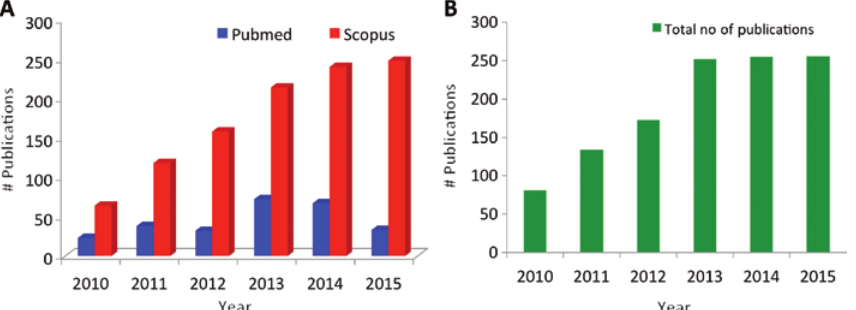
Figure 8: Publication trends. (A) Yearwise distribution of number of publications retrieved from Pubmed and Scopus. (B) Yearwise distribu- tion of the total number of publications from Pubmed and